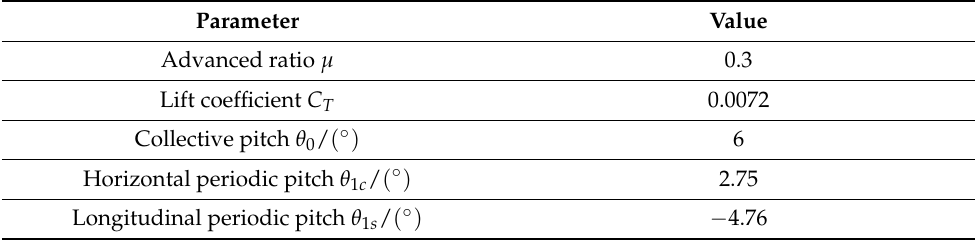
Table 1. Parameters in forward